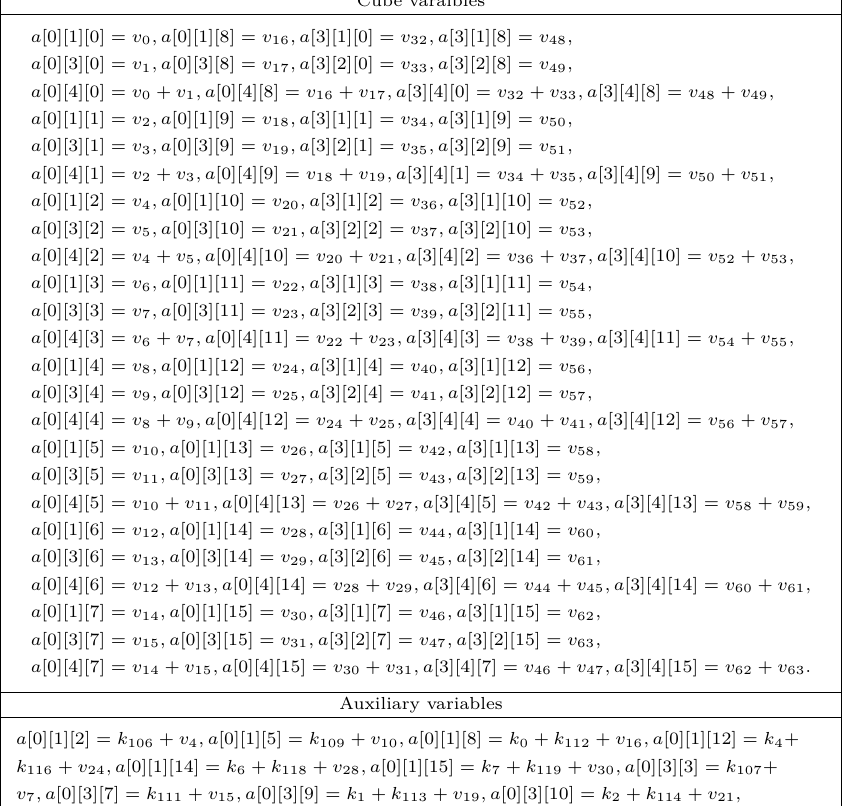
Table 14: A 64-dimensional cube for Ketje Sr V2, where ( n a , n i ) = (33 , 33). In total, there are 60 bits key information involved in both auxiliary variables and involved key